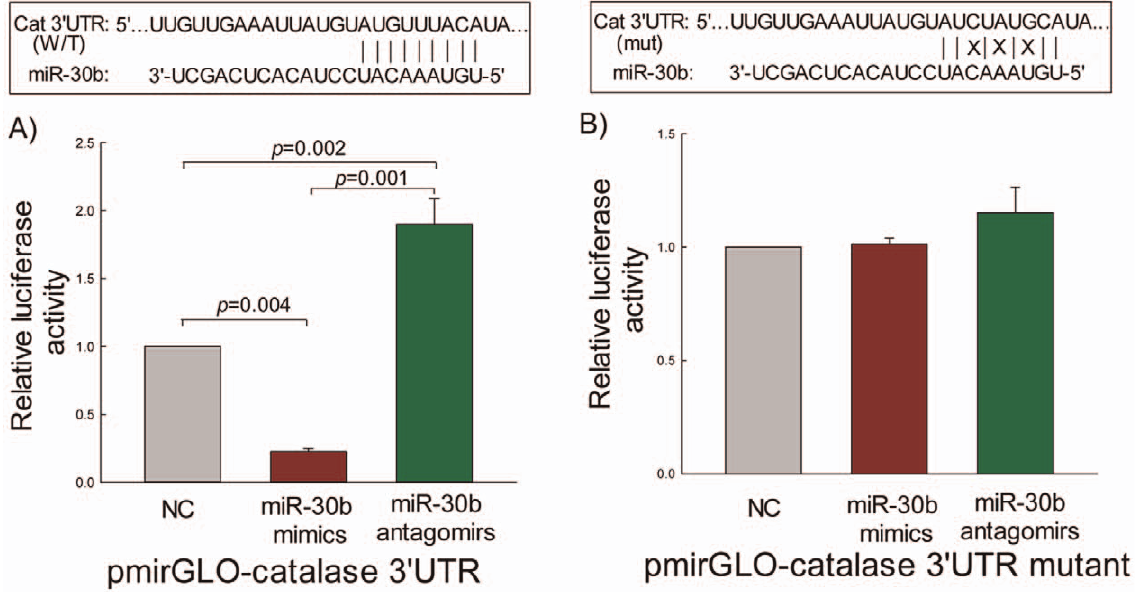
Figure 5. miR-30b interacts with the human catalase 3 9 UTR. ARPE-19 cells were co-transfected with wild-type (WT, Figure 5A ) or mutant (mut, Figure 5B ) catalase 3 9 -UTR s and 20 nM scrambled miRNA (NC), 20 nM mimics, or 50 nM antagomirs using Lipofectamine TM 2000 transfection reagent. Cells were harvested 24 h post-transfection for measuring luciferase activities by the dual luciferase reporter assay system, as described in ‘Materials and Methods’. The Firefly luciferase activity was normalized with the Renilla luciferase activity. The levels of luciferase activity of miR-30b mimics and miR-30b antagomirs groups were compared with those of NC-transfected cells; NC values were set to 1. Values are the means 6 SEM of relative luciferase activity over NC after normalization to the Renilla luciferase activity from two independent experiments in triplicate. Sequences of wild-type or mutant (3 bp mutation within the seed region) target site for miR-30b in catalase 3 9 -UTR are shown above the figure. The levels of significance between the groups are shown inside the figure (5A).